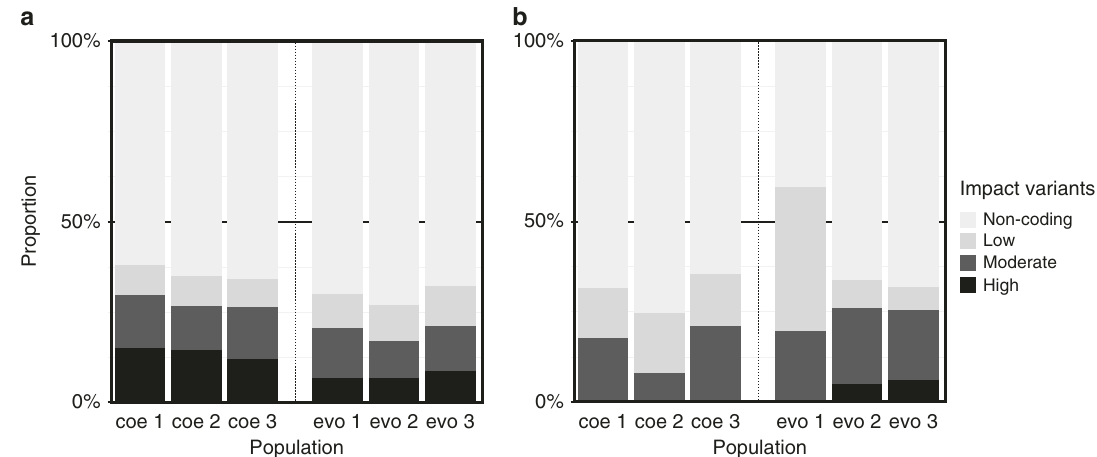
Fig. 3 Relative abundance of variants with different impact effects. The proportion of variants per impact class for each population is shown. High = frameshift, splice donor variant, Moderate = missense variant, Low = synonymous variant, Non-coding = variant in intron or intergenic region. Abbreviations coe1 – coe3 correspond to the three coevolved populations (Fig. 1a). Abbreviations evo1 – evo3 correspond to the three evolved populations (Fig. 1b). a Distribution of all derived variants. b Distribution of high frequency variants (see Fig.